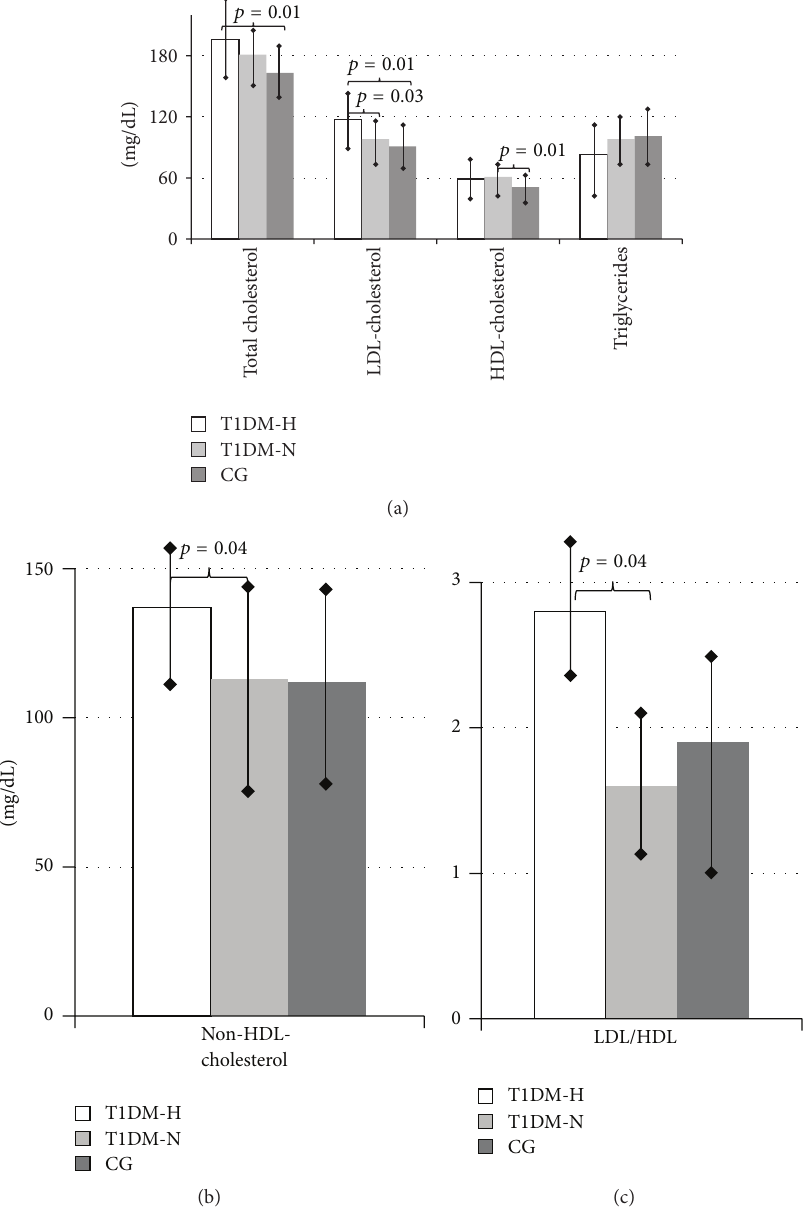
Figure 1: Lipid profile of adolescent girls with type 1 diabetes mellitus with (T1DM-H) and without hyperandrogenemia (T1DM-N) and healthy, regularly menstruating girls with normal androgen level (control group,